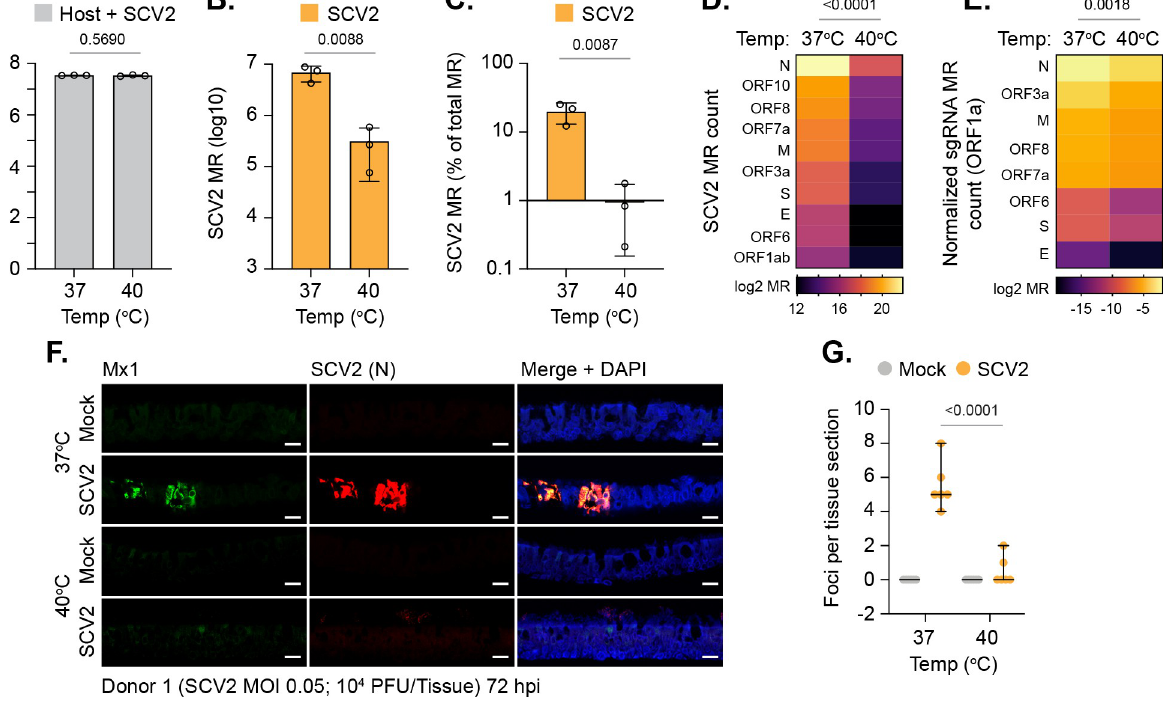
Fig 7. Elevated temperature restricts SARS-CoV-2 transcription in respiratory airway cultures. Ciliated respiratory cultures differentiated from primary HBEp cells isolated from 3 independent donors (donor 1, male Caucasian aged 63 years; donor 2, Hispanic male aged 62 years; donor 3, Caucasian female aged 16 years; all nonsmokers) were incubated at 37 or 40˚C for 24 h prior to mock (media only) or SARS-CoV-2 (SCV2; MOI 0.05, 10 4 PFU/Tissue) infection. Tissues were incubated at their respective temperatures for 72 h prior to RNA extraction and RNA-Seq. (A) Total MRs (host + SARS-CoV-2) from infected tissues; means and SD shown; p -value shown, unpaired two-tailed t test. (B) SARS-CoV-2 MRs from infected tissues; means and SD shown. (C) % SARS-CoV-2 MRs of total MR count (human + SARS-CoV-2); means and SD shown. (B/C) Unpaired two-tailed t test, p -value shown. (D) Expression values (log2 MR) of SARS-CoV-2 ORFs. (E) Expression values (log2 sgRNA count normalized to ORF1a) of SARS-CoV-2 sgRNAs. (D/E) Paired two-tailed t test, p -values shown. (A to E) RNA-Seq data derived from RNA isolated from 3 donors (donors 1 to 3) per sample condition derived from 3 independent experiments per donor. (F) Indirect immunofluorescence staining of tissue sections (donor 1) showing ISG Mx1 (green) and SARS-CoV-2 nucleocapsid (N, red) expression. Nuclei were stained with DAPI. Scale bars = 20 μ m. (G) Quantitation of SARS-CoV-2 N foci in respiratory tissue sections (as in F). N = 6 tissue sections per sample condition. Black line, median; whisker, 95% confidence interval; all data points shown; p -value shown, unpaired two-tailed t test. Raw values presented in S9 Data. HBEp, human bronchiolar epithelial; ISG, IFN-stimulated gene; MR, mapped read; PFU, plaque-forming unit; SARS-CoV-2, Severe Acute Respiratory Syndrome Coronavirus 2; sgRNA, subgenomic